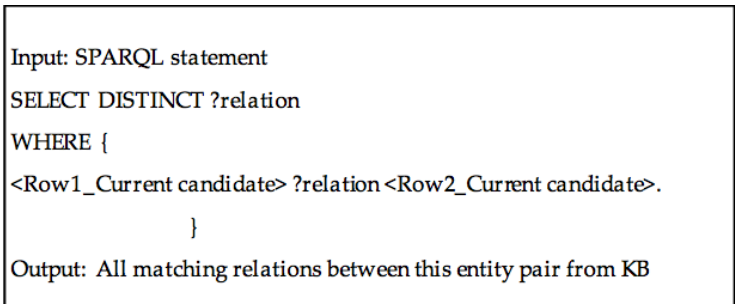
Figure 6. The SPARQL query used for generating candidate relations.